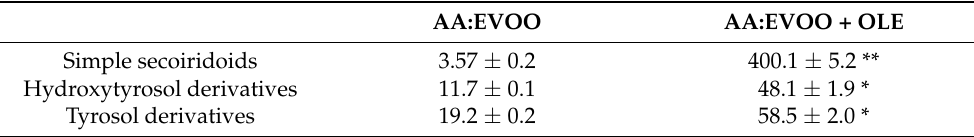
Table 1. Phenolic fraction (mg/g oil) of the oil mixture in presence/absence of the OLE.